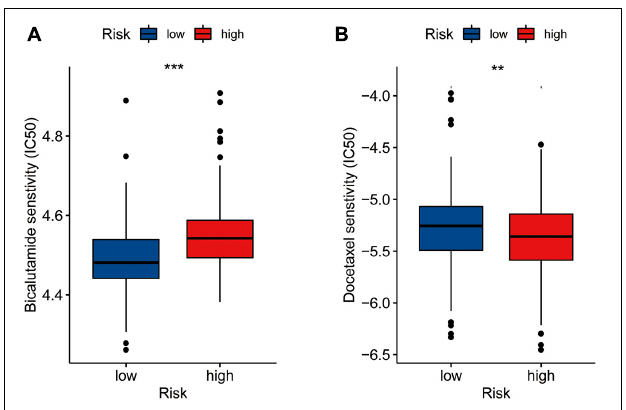
FIGURE 6 | Drug sensibility analysis with risk model. Differences in the IC50 of five drugs [bicalutamide (A) , docetaxel (B) ] in the high- and low-risk groups (** P < 0.01, *** P < 0.001).